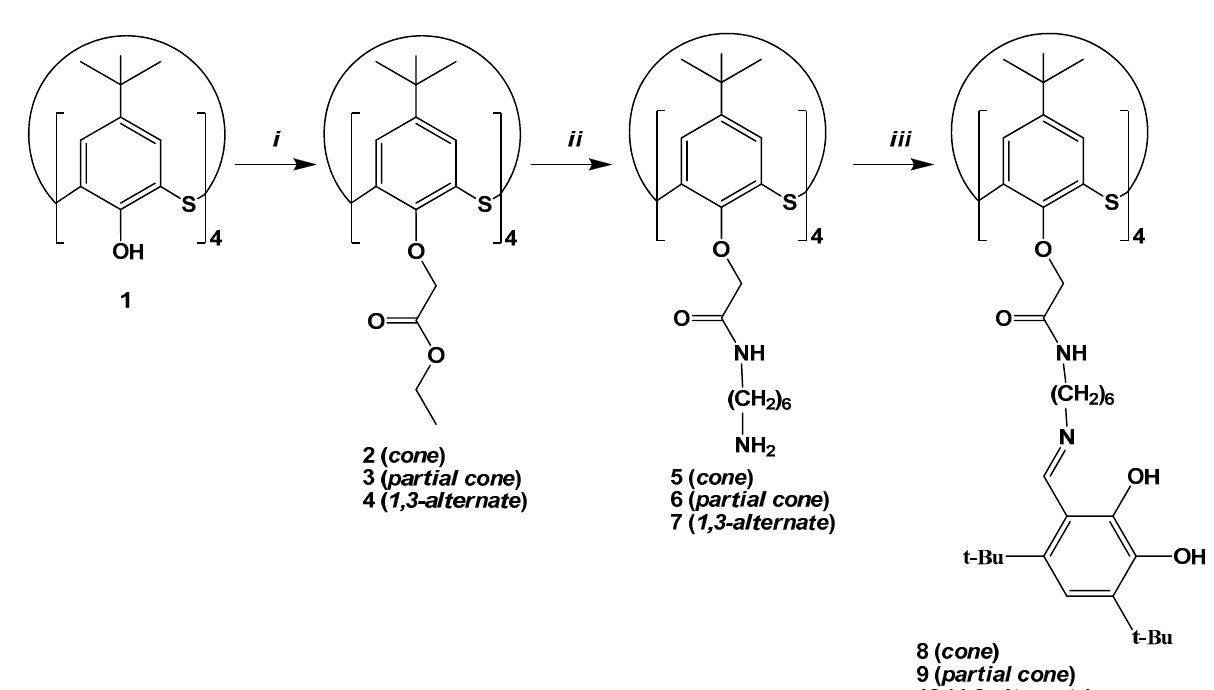
(Figure 1) in high yields (91–96%). 4,6-Di- tert -butyl-1,2-dihydroxybenzaldehyde is a convenient synthetic block for the synthesis of oligomeric Schiff bases with catechol or o -quinone fragments, redox-active ligands for coordination chemistry. Due to the presence of tert -butyl groups, it is possible to isolate corresponding o -benzoquinones and register the oxidized forms of catecholate complexes. This aldehyde also has the potential to act as both an O , O -chelating moiety and an O , N -chelating moiety [45–47]. Unlike vanillin derivatives, it can participate in the formation of dimeric structures via intermolecular hydrogen bonds. Monomeric com- pound 11 (Figure 1) was synthesized with a yield of 90% in a similar synthetic way to compare complexing properties of the obtained macrocyclic compounds. The structure and composition of the obtained compounds 8 – 11 were confirmed by modern physical methods, e.g., 1 H, 13 C NMR, IR spectroscopy, high-resolution mass spectrometry (HRMS), and elemental analysis (Figure S1–S16).